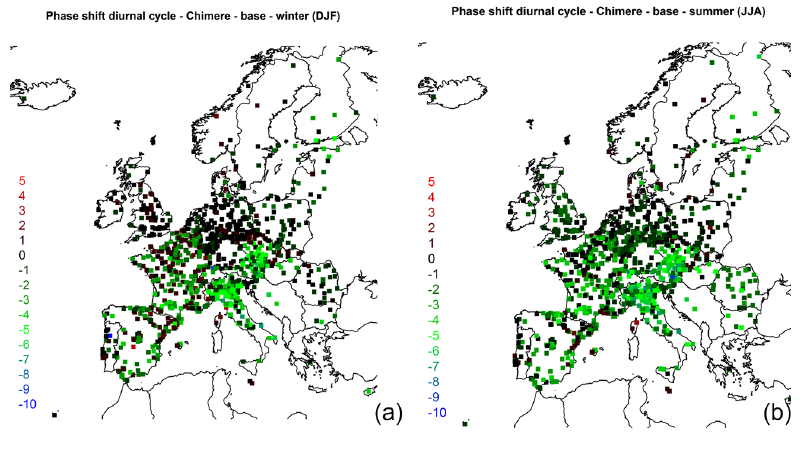
Figure 25. As in Fig. 24 for EU.